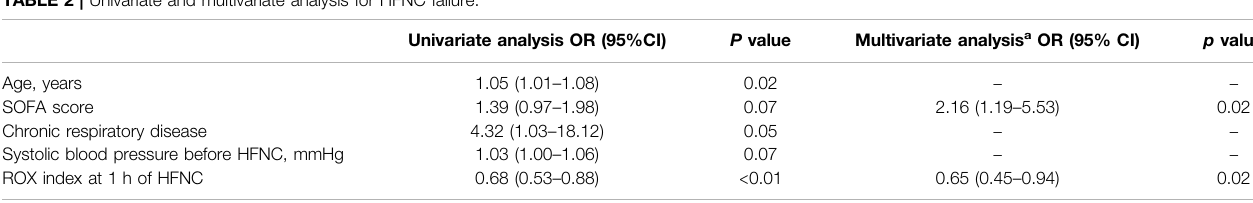
TABLE 2 | Univariate and multivariate analysis for HFNC failure.